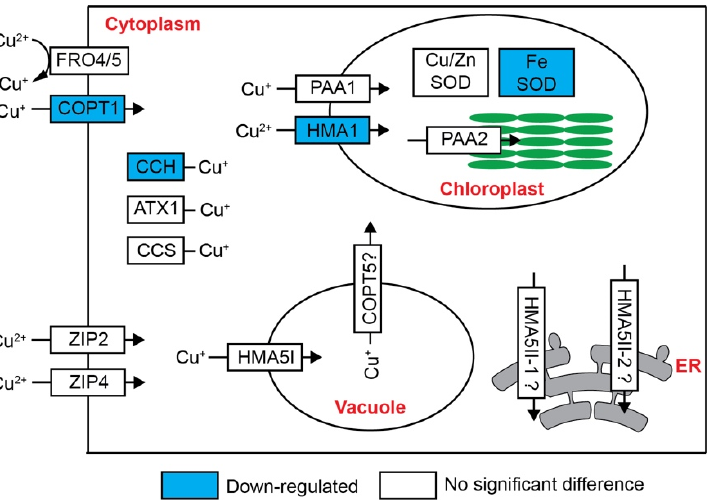
Figure 4. Expression pattern of genes relate to Cu transport and distribution in petunia petal under excess Cu. Blue box indicates down-regulated genes, whiter box indicates no significant difference after excess Cu treatment. FRO, ferric reductase oxidase; COPT, copper transporter; ZIP, zinc and iron regulated transporter proteins; HMA, heavy metal P-ATPase; CCH, copper chaperone; CCS, copper chaperone for superoxide dismutase; ATX1, antioxidant 1; PAA1, HMA6; PAA2, HMA8; ER, endoplasmic reticulum. Table 1. Expression profiles of genes involved in Cu and Fe homeostasis.